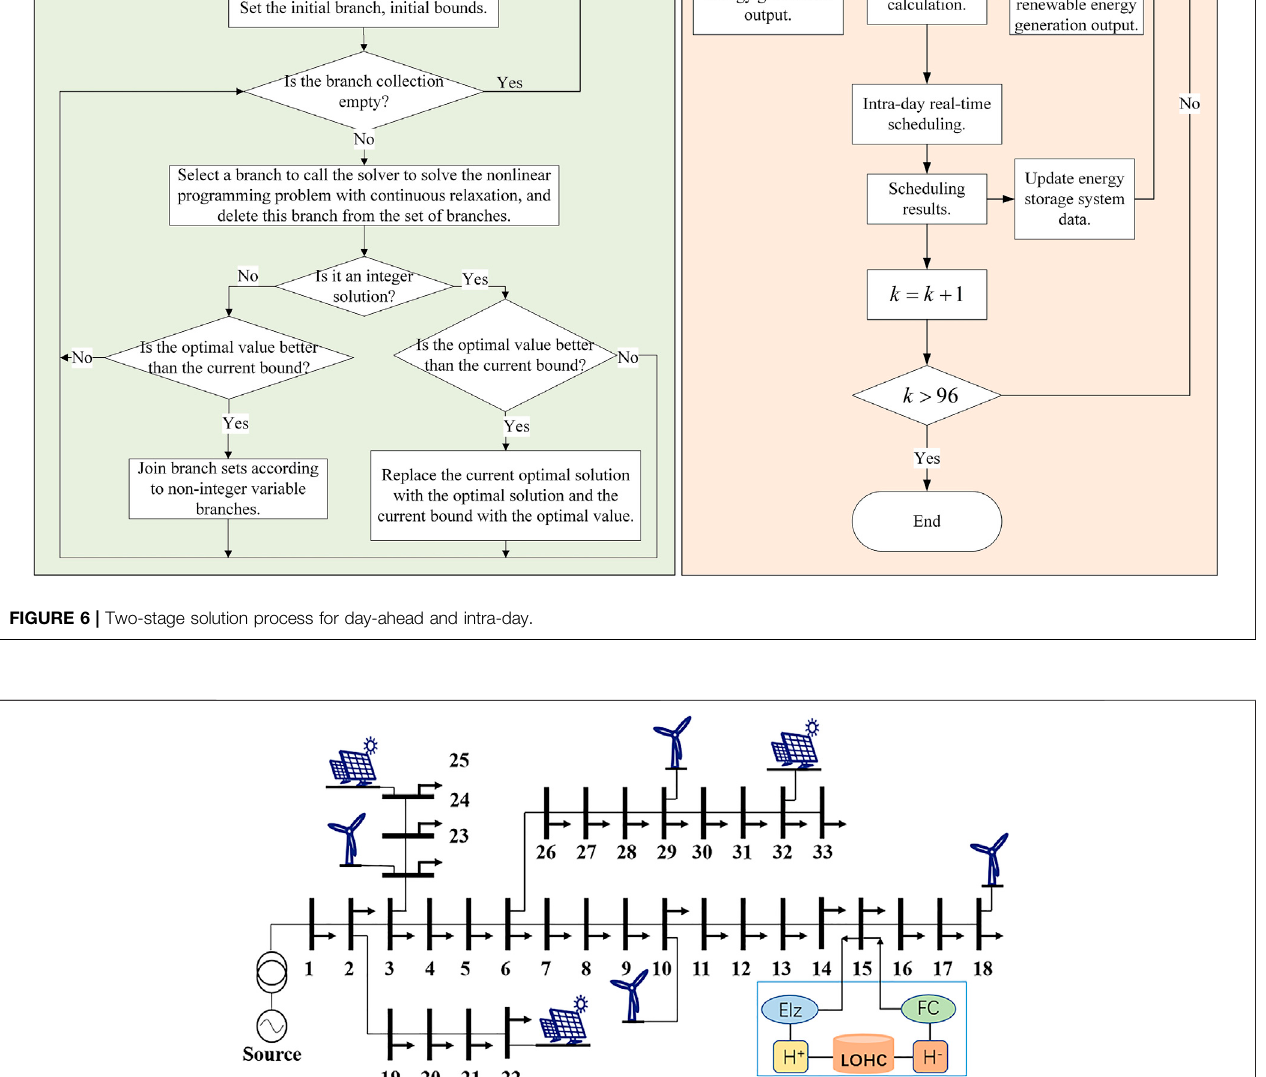
Frontiers in Energy Research |